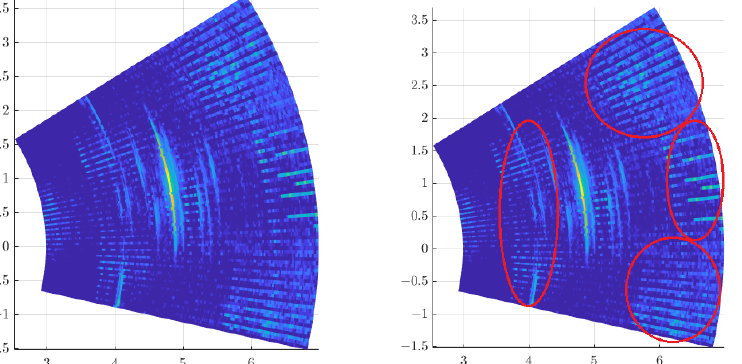
Figure 3. Examples of noise in sonar imaging. The red marks highlight the disturbances caused by reflections in combination with the high angular resolution of the space scan. To avoid this type of interference pre-processing operations must be performed, together with the tuning of the detection parameters. [own